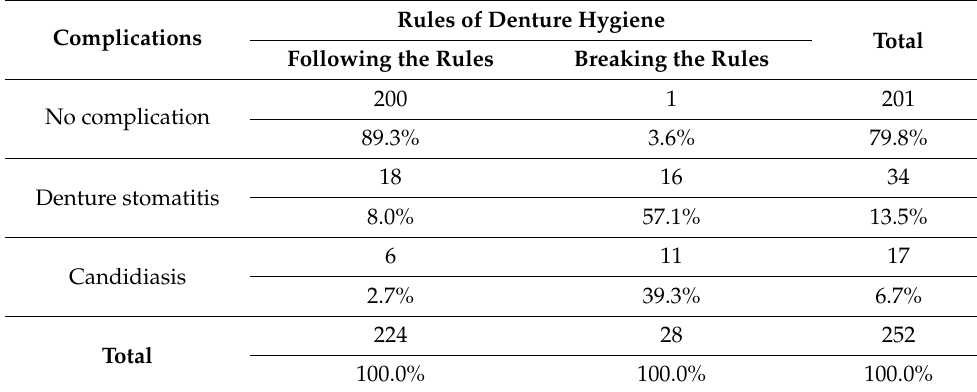
Table 6. Complications crosstabulation hygiene